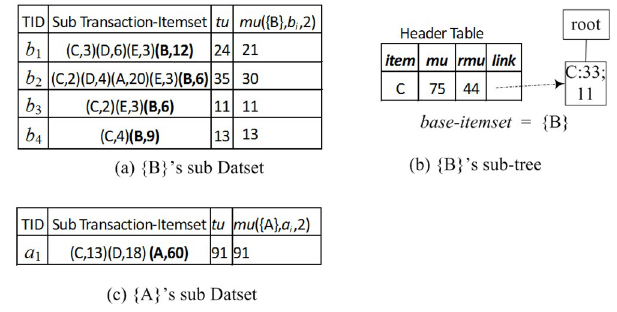
Fig 3. The HUIL-TN algorithm for mining high utility